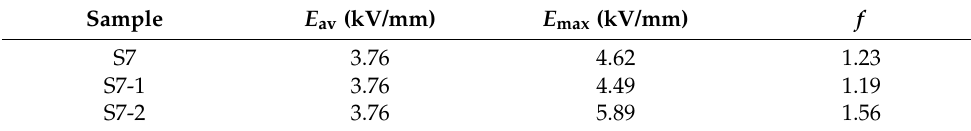
Table 4. The f of the cables before and after the electrothermal combined aging test.